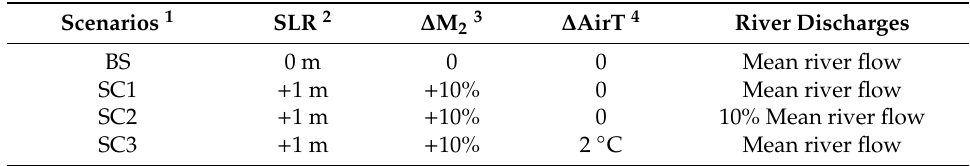
Table 3. The scenarios description, combining the e ff ects of, the sea level rise, SLR, the M 2 amplitude, the river discharge and the air